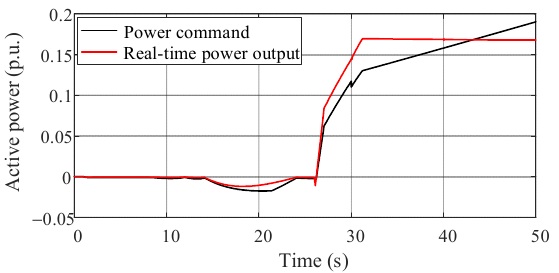
Figure 19. The power command curve and the real-time power output curve of HESS in case I.